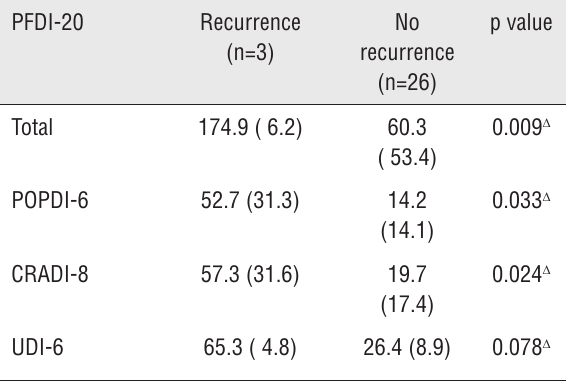
Table 2 – Characteristics of the surgery.